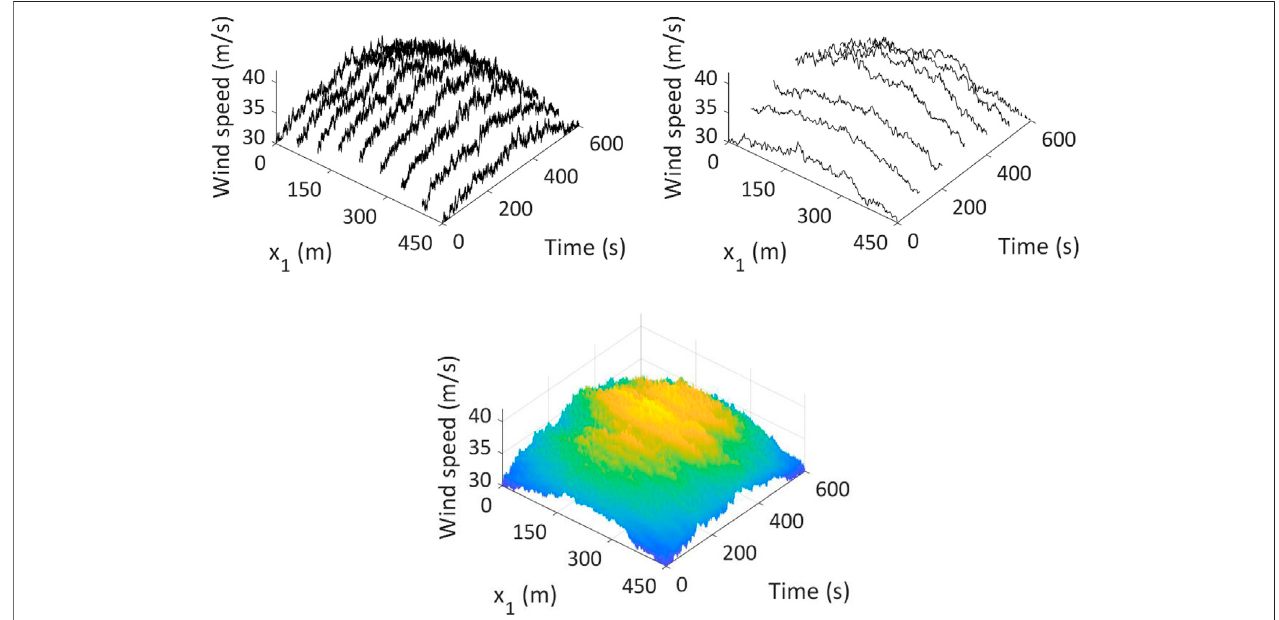
FIGURE 5 | Simulated nonstationary and nonhomogeneous line wind fi eld, including the mean wind velocity: (A) shows simulated wind velocity plus the mean wind velocity at a few selected locations, (C) represents the wind velocity fi eld at a few selected time, and (B) shows the propagating wind fi eld along the bridge deck.